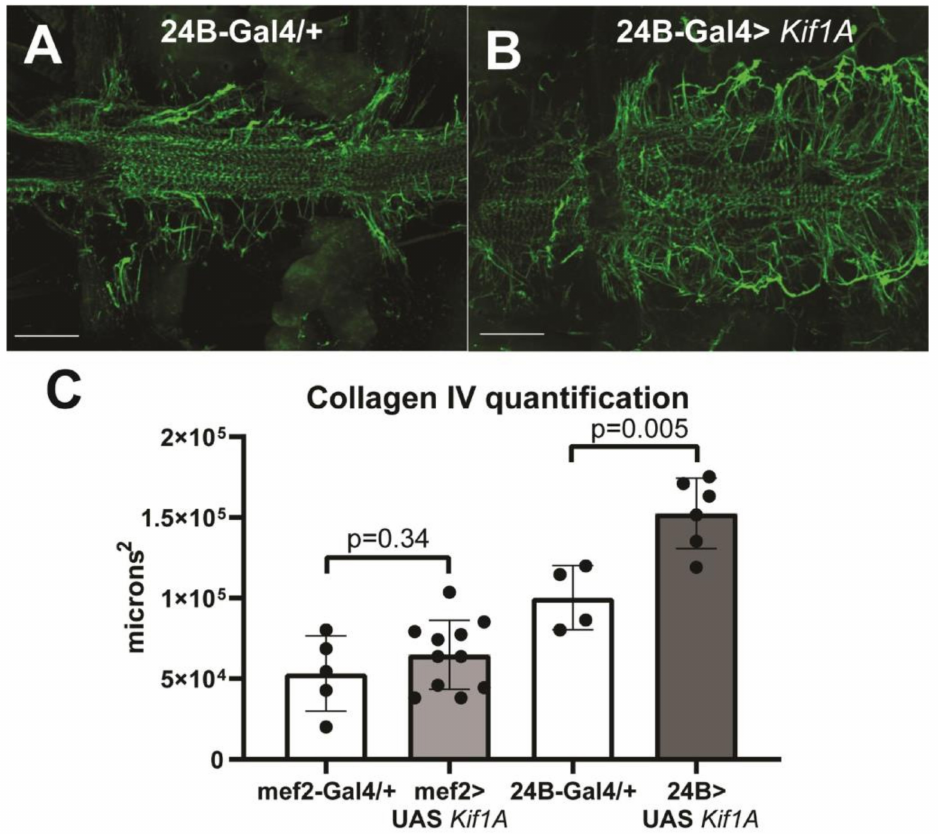
Figure 4. Kif1A overexpression increases collagen IV deposition: ( A ) Anti-pericardin (collagen IV homolog) staining reveals the extracellular matrix structure surrounding the cardiac tube in control flies expressing the muscle cell driver 24B-Gal4. ( B ) Muscle-specific Kif1A overexpression caused a significant increase in the extent of cardiac-associated collagen IV network. Scale bar is 50 microns; anterior is to the left. ( C ) Quantification of the ECM networks from Z-stacks shows significant increases in response to muscle cell-specific Kif1A OE. Significance was determined by two-tail, unpaired